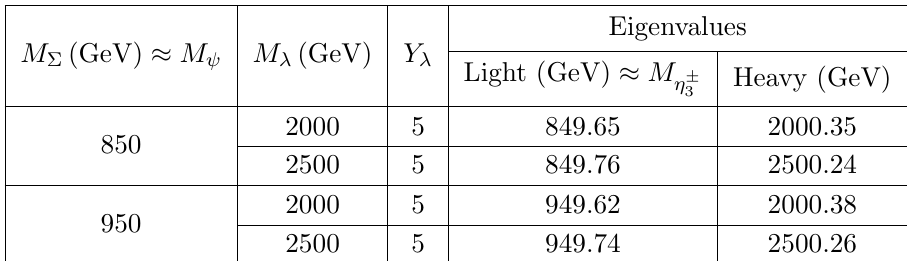
Table 6 . Eigenvalues of the nearly degenerate charged and neutral fermions for few benchmark points after mixing between the triplet fermion and vector-like heavy charged fermion. on the splitting between M and M one can have an additional signal, either single-track (cid:17) (cid:6) 3 events or two-track ones with a displaced vertex for one of the tracks. Results for the (cid:12)rst case alone have been presented in the